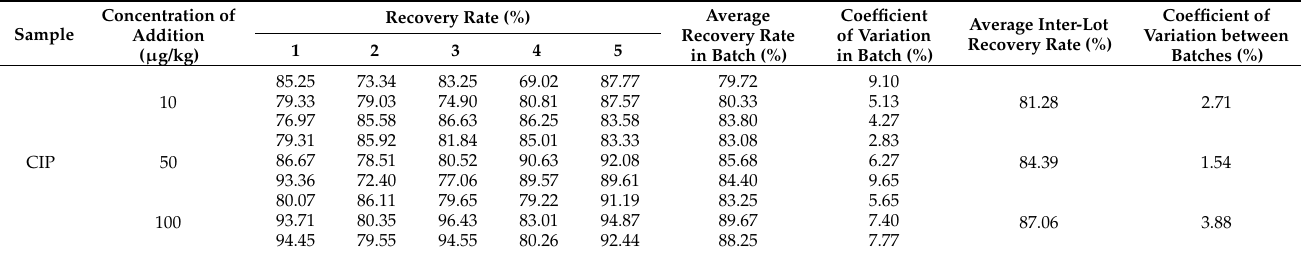
Table 3. The average recoveries and RSD for CIP, EF, and TIM in eggs